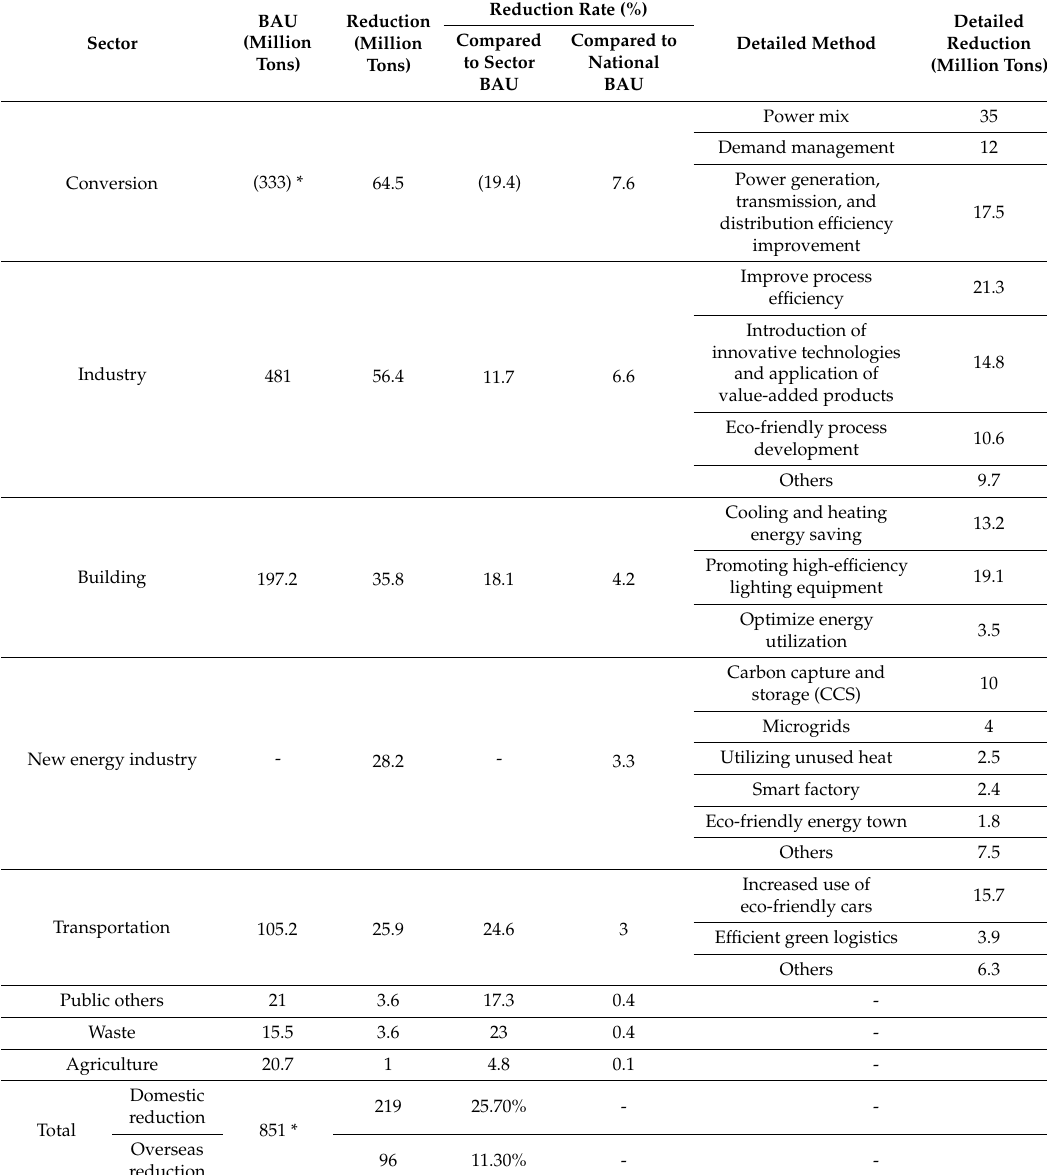
Table 4. Korea’s 2030 target reduction by